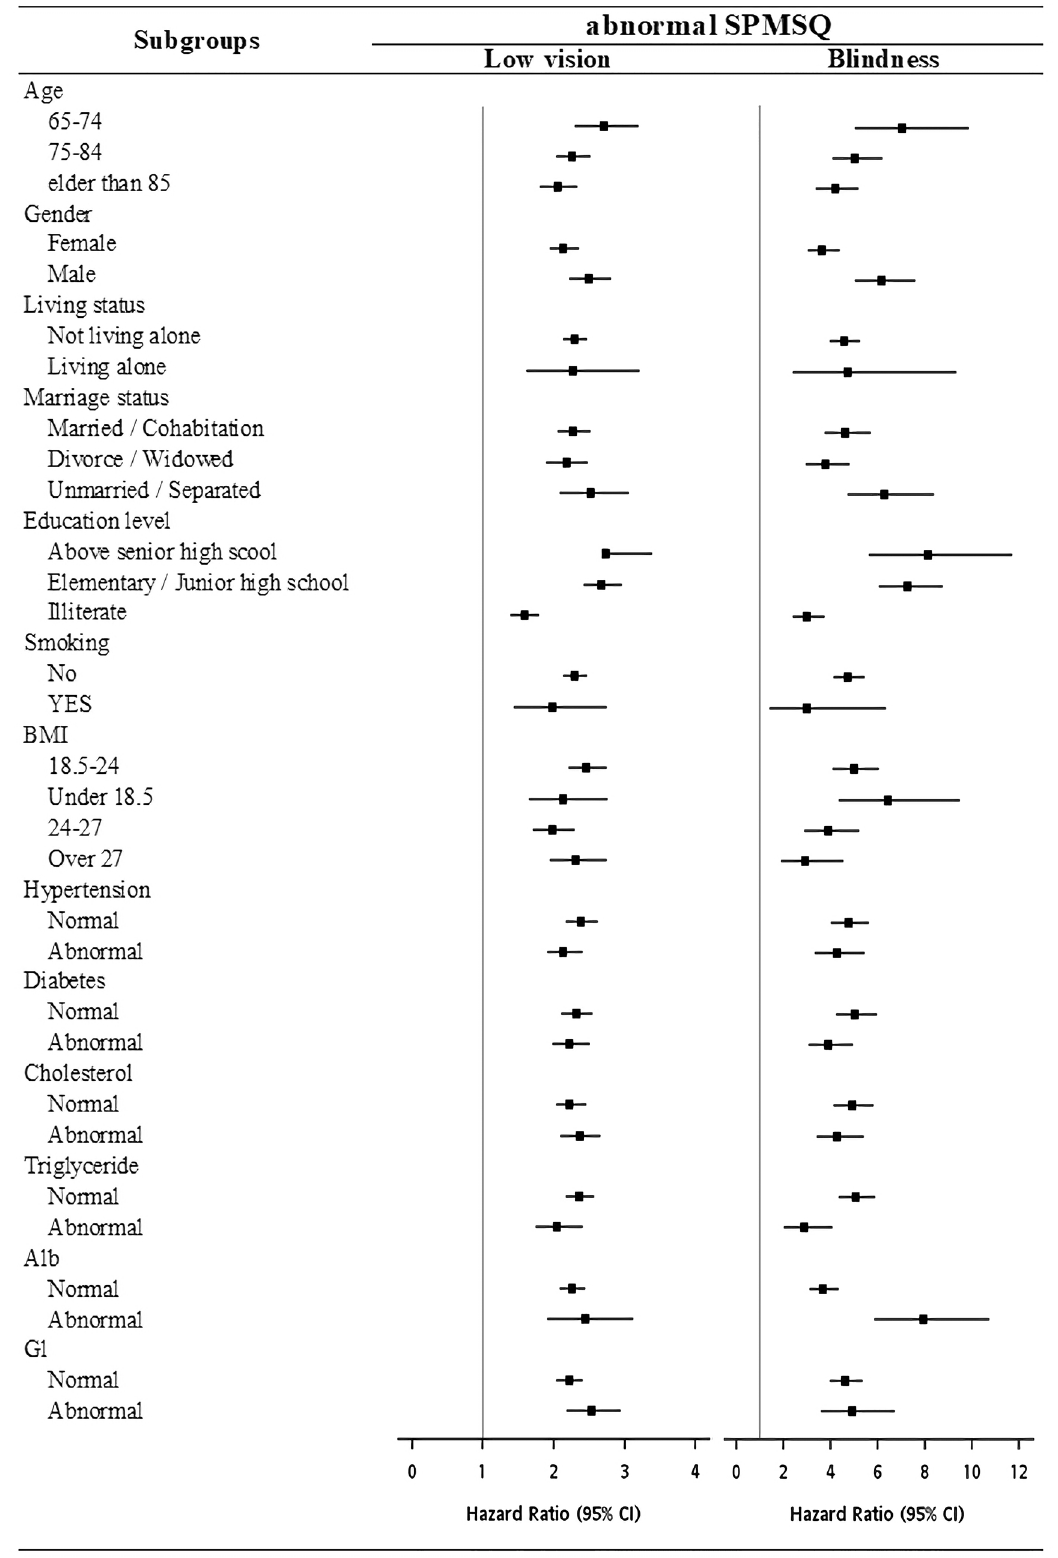
Figure 2. Forest plots of potential cognitive decline, as demonstrated by abnormal SPMSQ scores in each subgroup. Hazard ratios (HRs) were represented by the squares, and the horizontal lines crossing the square stood for the 95% confidence intervals (CIs). The HRs showed similar trends for each subgroup. In each subgroup, those with low vision and blindness were significantly associated with abnormal SPMSQ